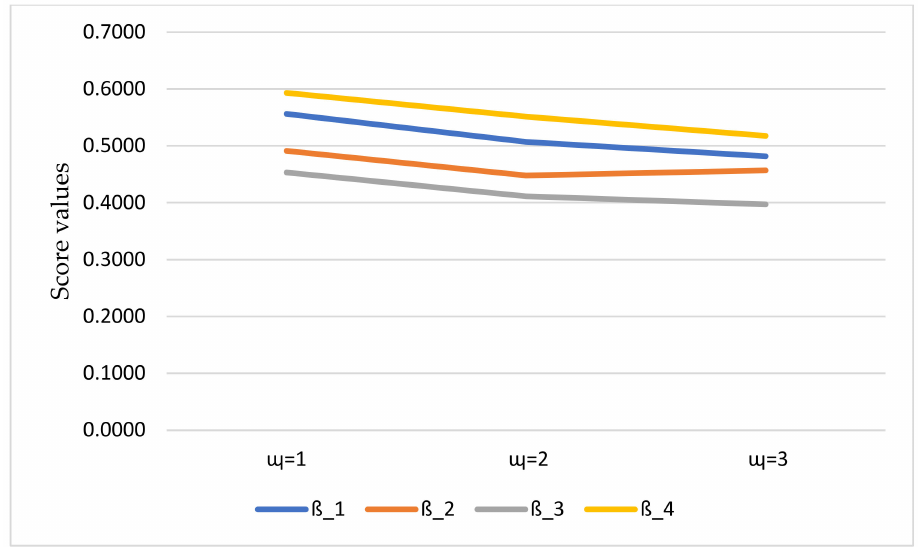
Figure 4. Results of the CPFWDHM operator for different values